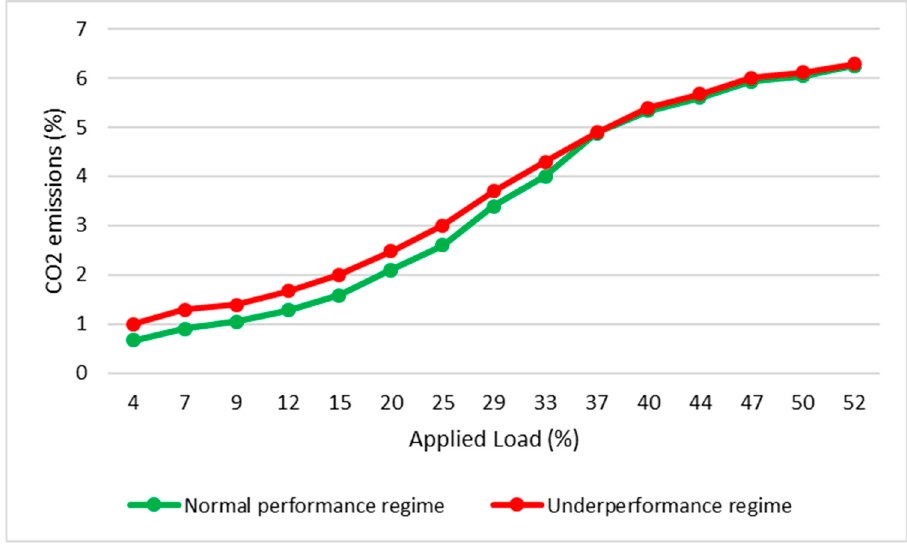
Figure 12. Variation of the CO 2 content in the exhaust gas according to the applied loads.